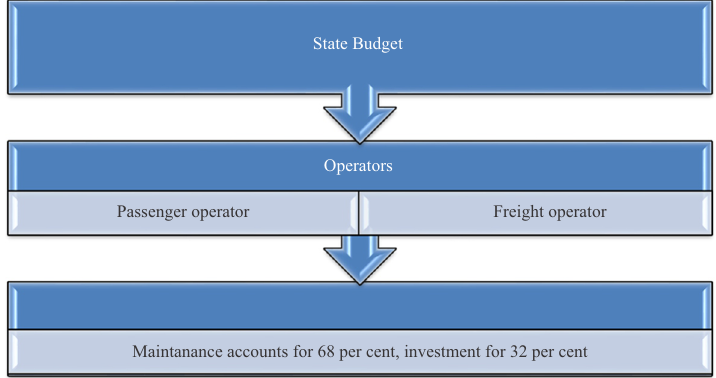
Fig 3. Money flow